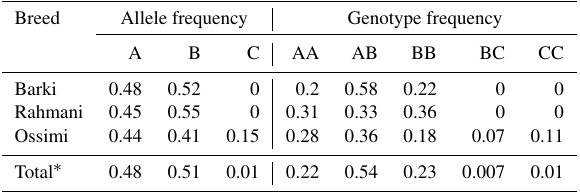
Table 3. Effect of breed on the studied wool traits in Egyptian sheep a . Traits